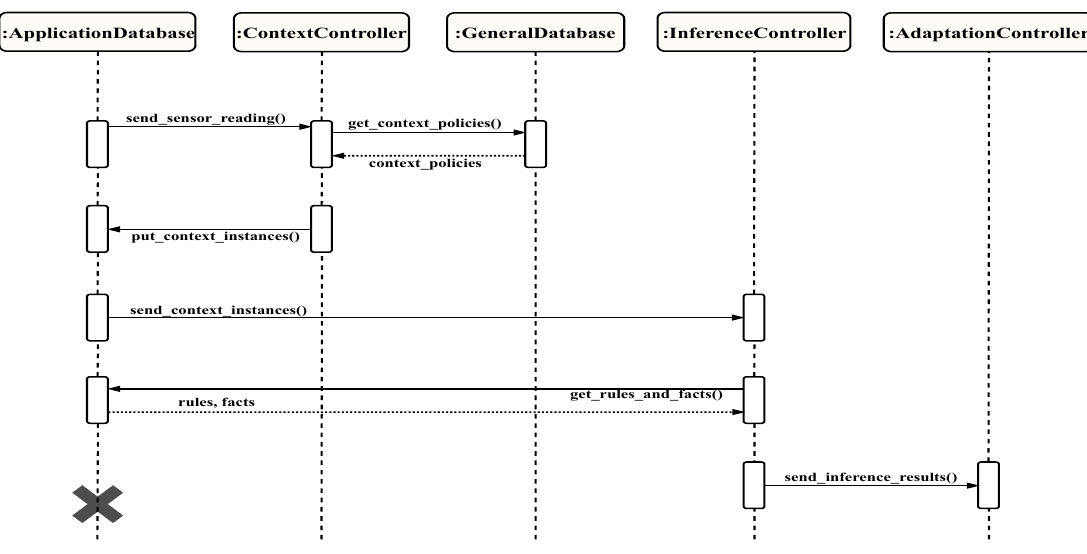
Figure 22. Process Step Database Interaction Sequence